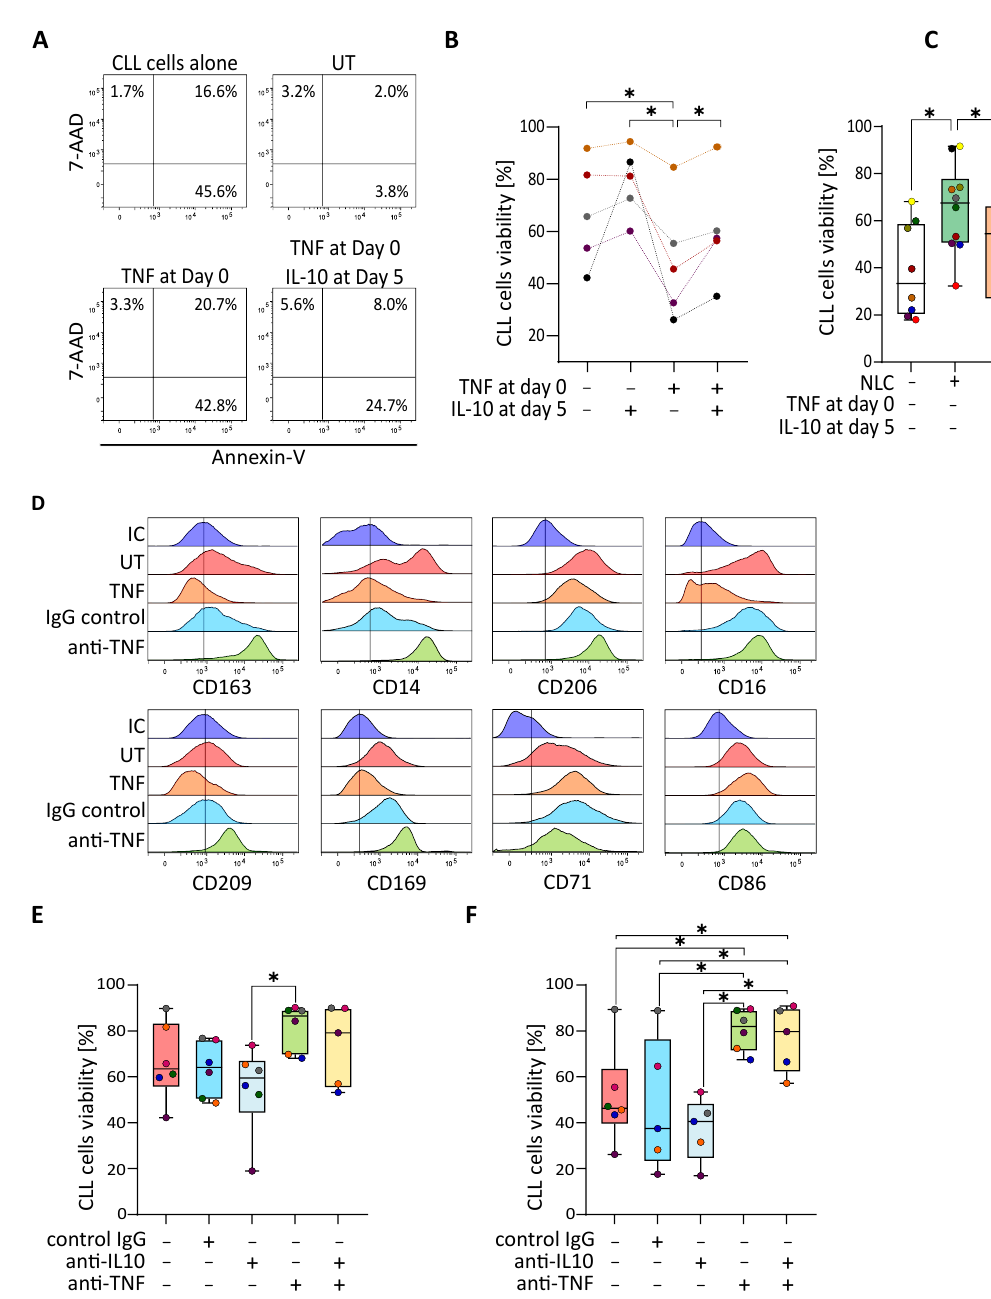
of CLL cells viability at 14 days of culture of CLL PBMC-incubated or not (UT) with TNF at day zero or at day six. ( D ) one representative experiment. ( E ) A total of 19 independent experiments for TNF treatment at day zero and 10 independent experiments at day six. ( F ) Co-culture experiments: percent- age of the CLL cells viability cultivated alone (white) or co-cultivated with autologous control NLC (untreated, green) or depolarized NLC (previously treated with TNF; orange). * indicates p < 0.05.